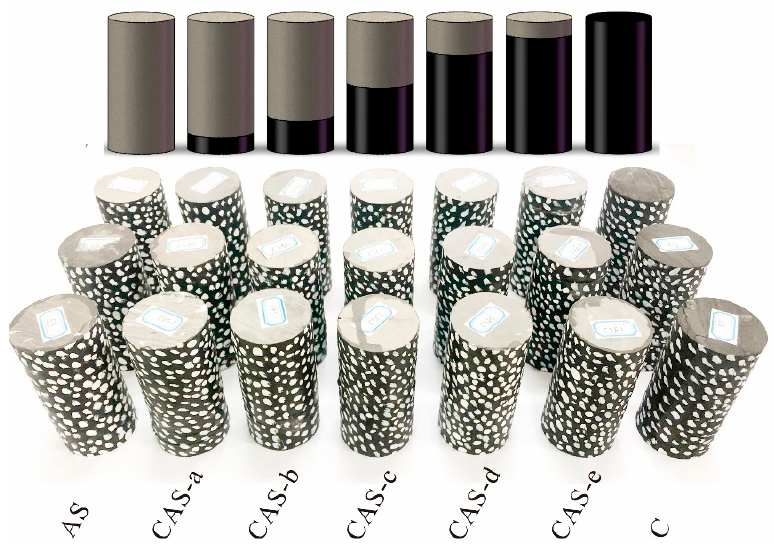
Figure 3. Coal–rock combination specimen and model; the specimen was subjected to surface speckle treatment.